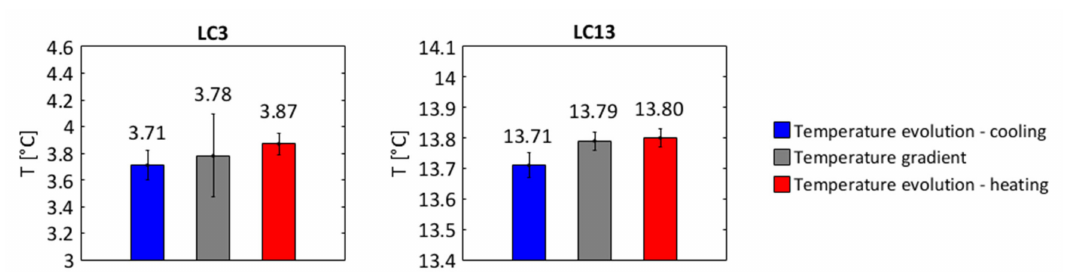
Figure 10. LC13 calibration values over time.